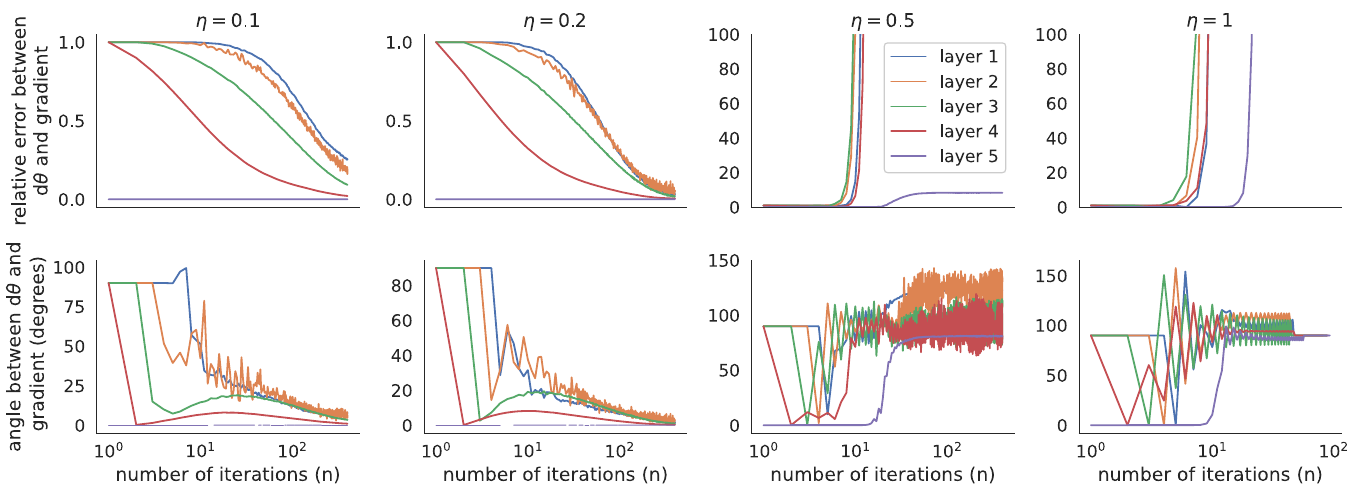
computed by backpropagation (relative error defined by k dθ k / k dθ k ). Updates pc − dθ bp bp ‘